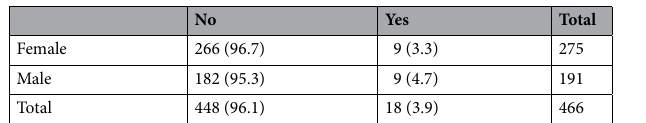
Table 1. FCRB distribution on right upper-extremity MR images [n (%)]. FCRB musculus flexor carpi radialis brevis, MR magnetic resonance.